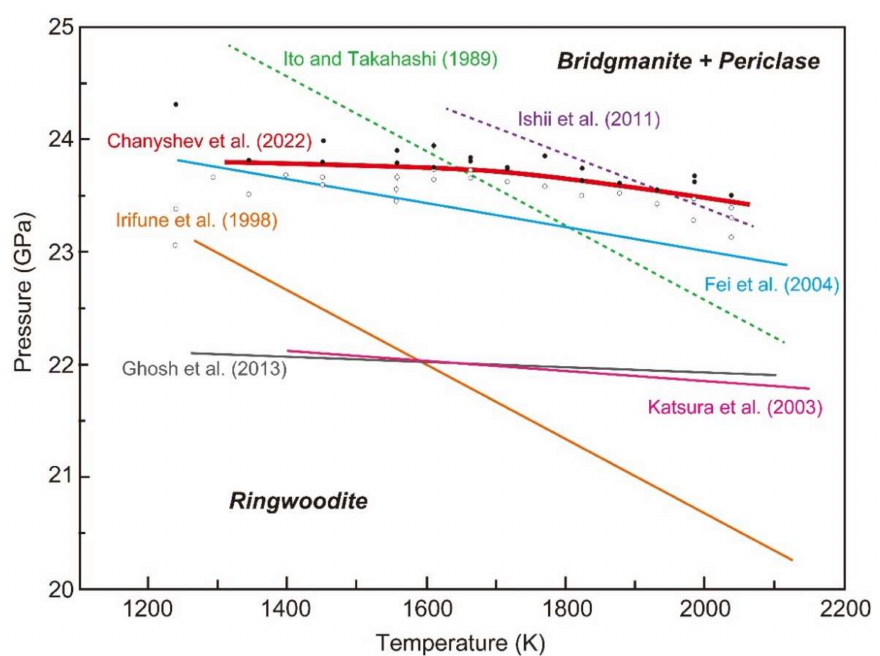
Figure 7. Comparison of the post-spinel phase boundary in Mg 2 SiO 4 obtained by the novel tech- nique with previously obtained boundaries. Dashed boundaries were determined by quench method. Solid lines were determined by in situ X-ray diffraction technique. Open and closed circles indicate stable pressure–temperature conditions for ringwoodite and bridgmanite + periclase, respectively